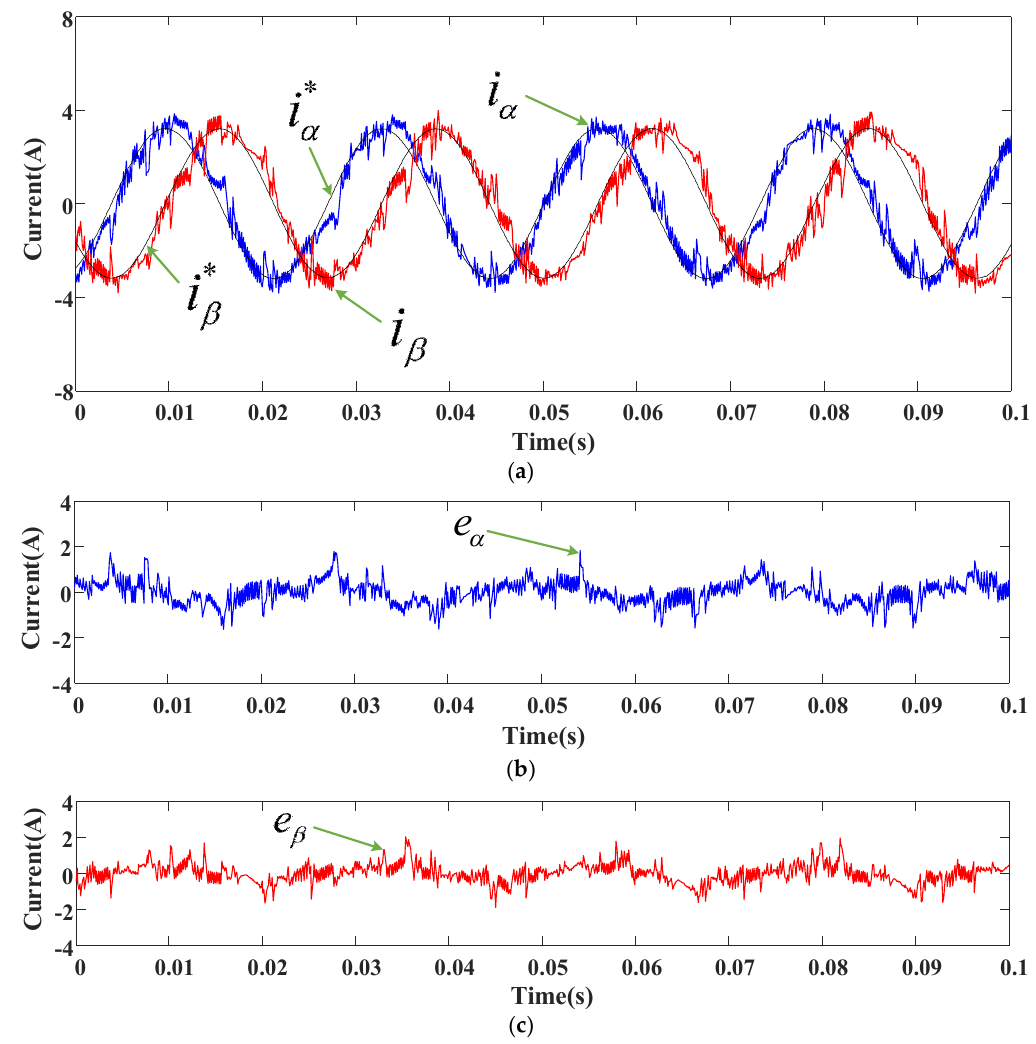
Figure 22. Experimental results of SVV-MFPCC under speed 1300 rpm and load 1 Nm (case 4): ( a ) current responses; ( b ) α -axis current error; ( c ) β -axis current error.